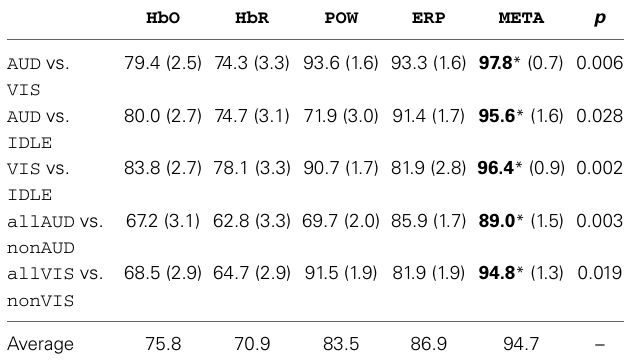
Table 2 | Stimulus-locked classification accuracies (in %) for subject-dependent classification.